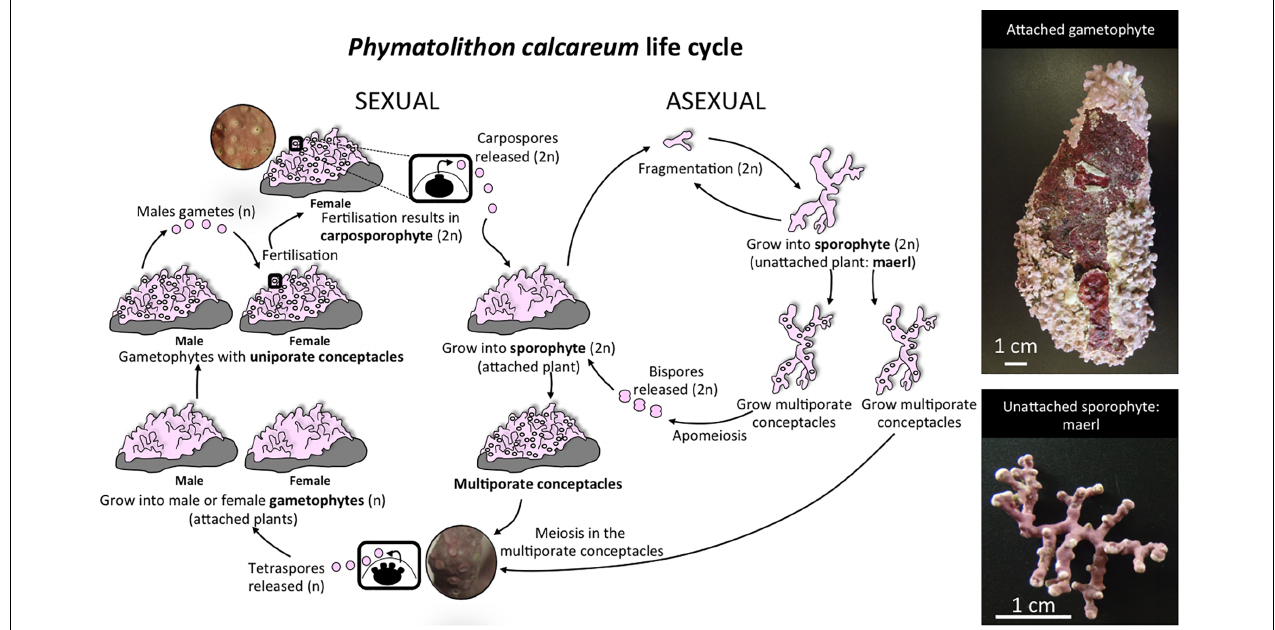
FIGURE 1 | The typical life cycle of maerl-forming species, including Phymatolithon calcareum . Sexual reproduction typically involves an alternation between diploid sporophytes and haploid male and female gametophytes. Regardless of their phase or sex, all spore recruits grow into encrusting-forms. The sporophyte (2n) produces, through meiosis, tetraspores (n) that are released and further develop as gametophytes. Male gametophytes (n) produce gametes by mitosis that are released and fertilize the gametes of female gametophytes (n) produced in uniporate conceptacles. Fertilization results in the formation of a zygote, which undergoes a complex series of changes that ultimately result in a diploid carposporophyte, retained on the female thallus. Carposphorophyte produces carpospores (2n) mitotically, which develop as sporophytes when they are released, completing the sexual cycle. Branches of encrusting growth-forms can break and grow into large unattached thalli that characterize the maerl (generally only reports of sporophytic maerl plants, Cabioch, 1969, 1970; Mendoza and Cabioch, 1998; Pardo et al., 2017). Fragmentation of branches from free-living maerl thalli can also occur enhancing the sporophyte vegetative reproduction (Bosence, 1976; Peña et al., 2014b; Pardo et al., 2017). Attached and unattached sporophyte thalli can also reproduce asexually by apomeiotic uninucleate bispores (Irvine and Chamberlain, 1994). Photos of an attached gametophyte (specimen with sexual uniporate conceptacles from Molène Archipelago described in Pardo et al., 2017, photograph by Cristina Pardo) and an unattached sporophyte (specimen with sexual multiporate conceptacles from Morlaix used in our study, photograph by Ignacio Bárbara) are given in the upper right hand corner and the lower right hand corner, respectively. Close-up from sexual uniporate conceptacles and multiporate conceptacles are given in circular inserts within the sexual life cycle. Please note that sporophytes of red algae producing tetraspores are commonly named tetrasporophytes in the literature.